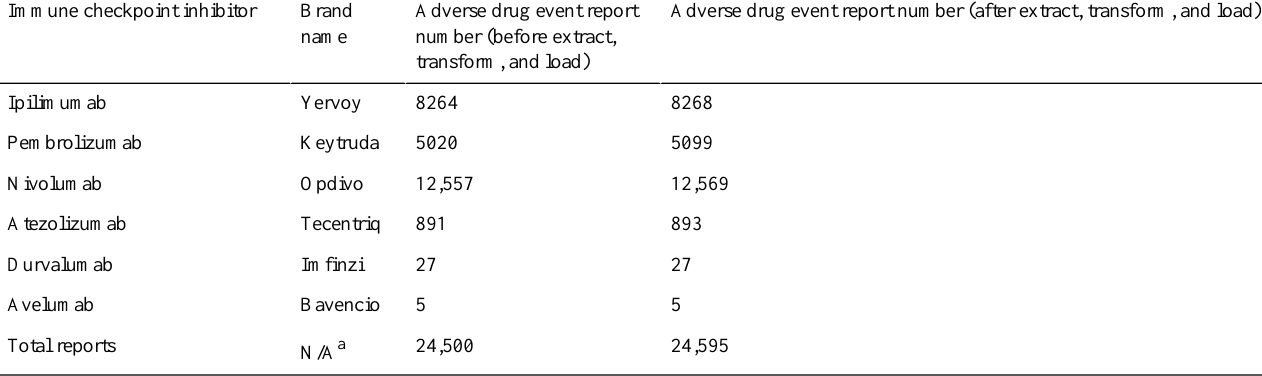
Table 3. Total report numbers of 6 immune checkpoint inhibitors.